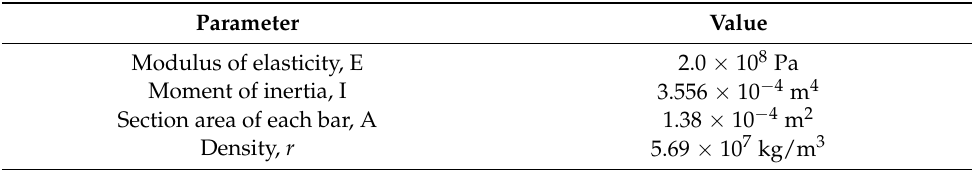
Table 1. Basic material parameters of the truss bridge.